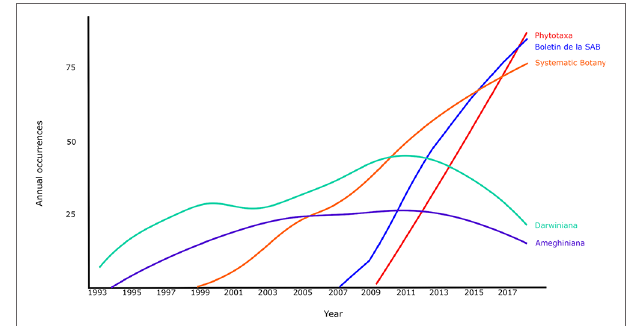
FIGURE 5 | Dynamics along time of the more frequent journal chosen to publish herbaria-based-research published from 1993 to 2018, based on the bibliometric analysis of publications stored at Scopus database (refer to the text to see filters of the search).